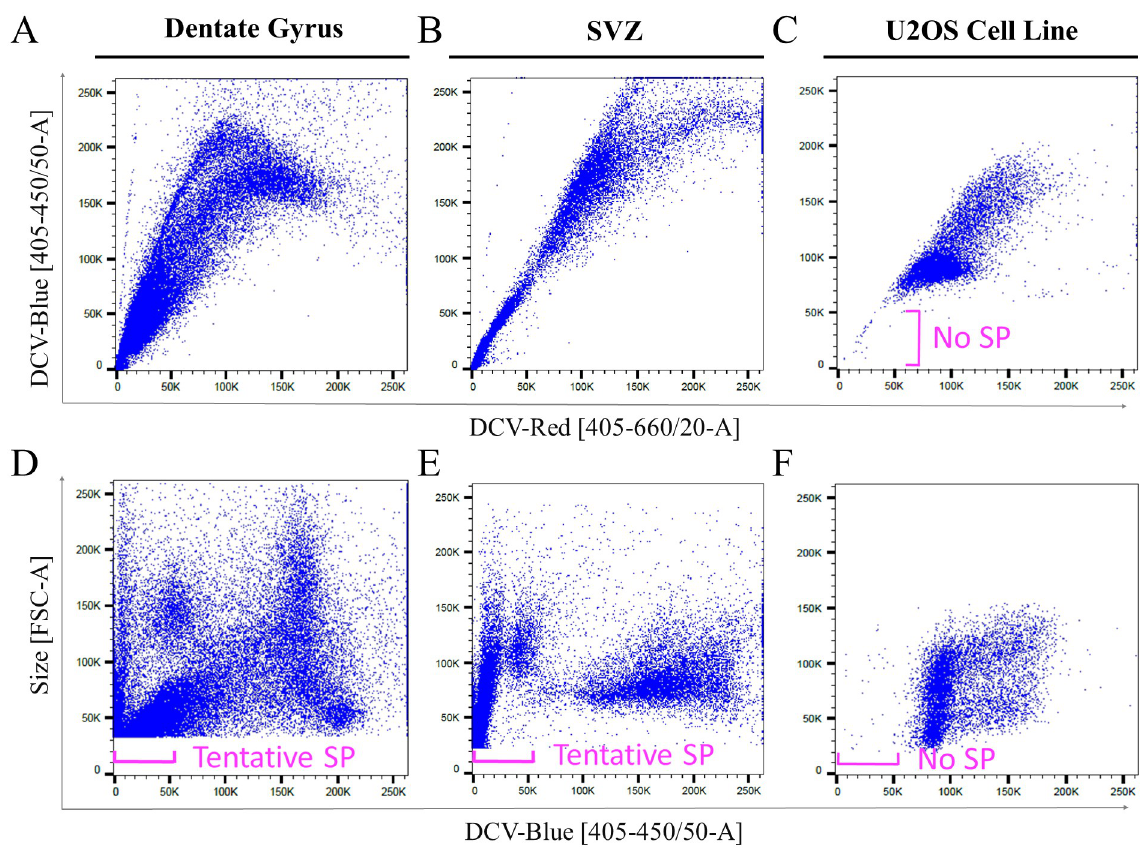
Fig 1. DCV identifies heterogeneous cell populations in primary neurogenic brain cells. Cell heterogeneity is illustrated in dual fluorescence DCV-Red vs DCV-Blue plots with adult cells isolated from the dentate gyrus (A), SVZ (B), as well as control cultured U2OS cells (C) that do not have a side population. Forward scatter (size) and DCV-Blue combined plots for dentate gyrus (D) and SVZ (E) show multiple low- fluorescence populations that could be bona fide side populations (labeled as Tentative SP), whereas, U2OS cells (F) show a few scattered cells that are debris and nuclear fragments. Plots A and D are representative plots based on samples pooled from two male and ten female mice. Plots B and E are representative plots based on samples pooled from two male and seven female mice.